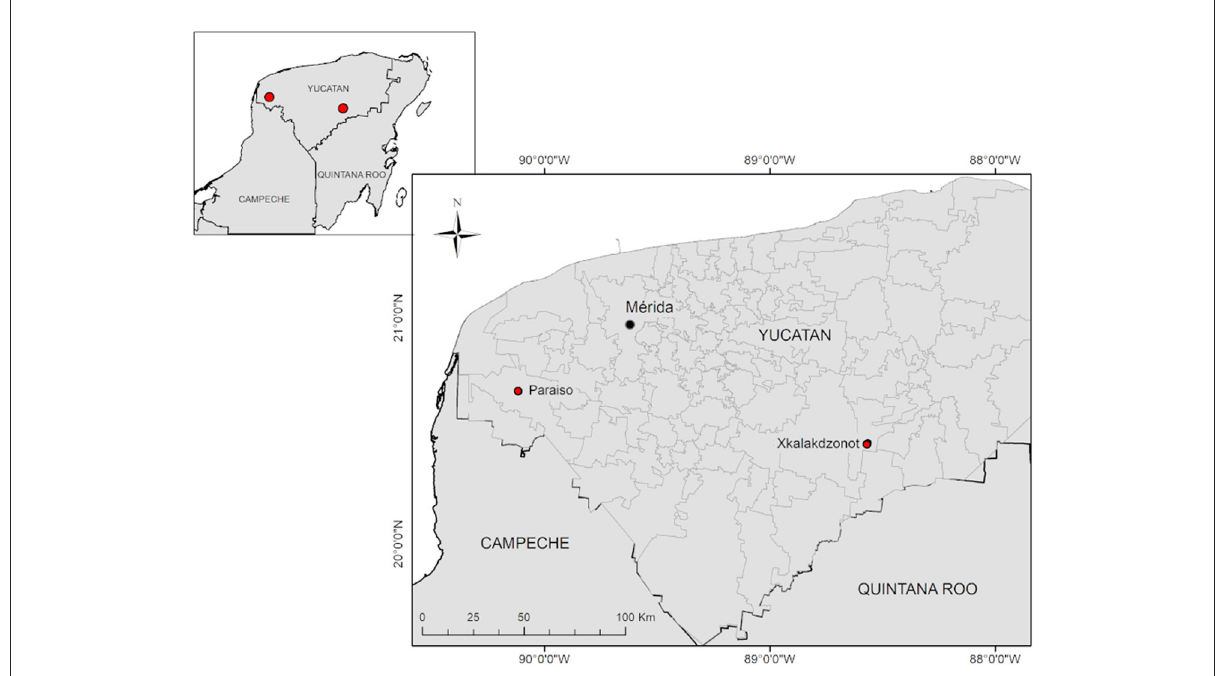
FIGURE1 Map of the geographical location of the Mayan communities studied in Yucatan, Mexico. Paraiso (PSO) located in the municipality of Maxcanú, and Xkalakdzonot (XKT) located in the municipality of Chankom.